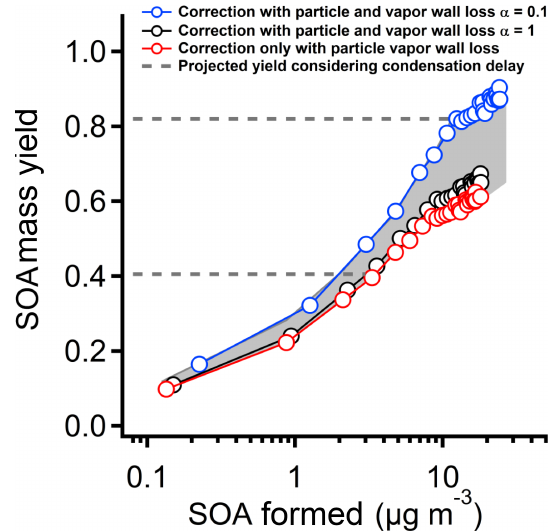
Figure 9. The SOA yield from pinanediol photo-oxidation after cor- rection for particle wall loss and vapor wall loss using three differ- ent methods: correction for particle wall-loss only; correction for vapor wall loss with α = 1; and correction for vapor wall loss with α = 0.1. For the first two methods the mass yields are similar. For the third, when α = 0.1, the mass yield is 30% higher than for the other two methods. The horizontal dashed lines indicate the mass yields at a time equal to twice the gas-phase lifetime of vapors due to condensation or wall loss. Before this time (below the lines) the measured SOA yields may be biased low due to the delay between production and condensation to the suspended particles.